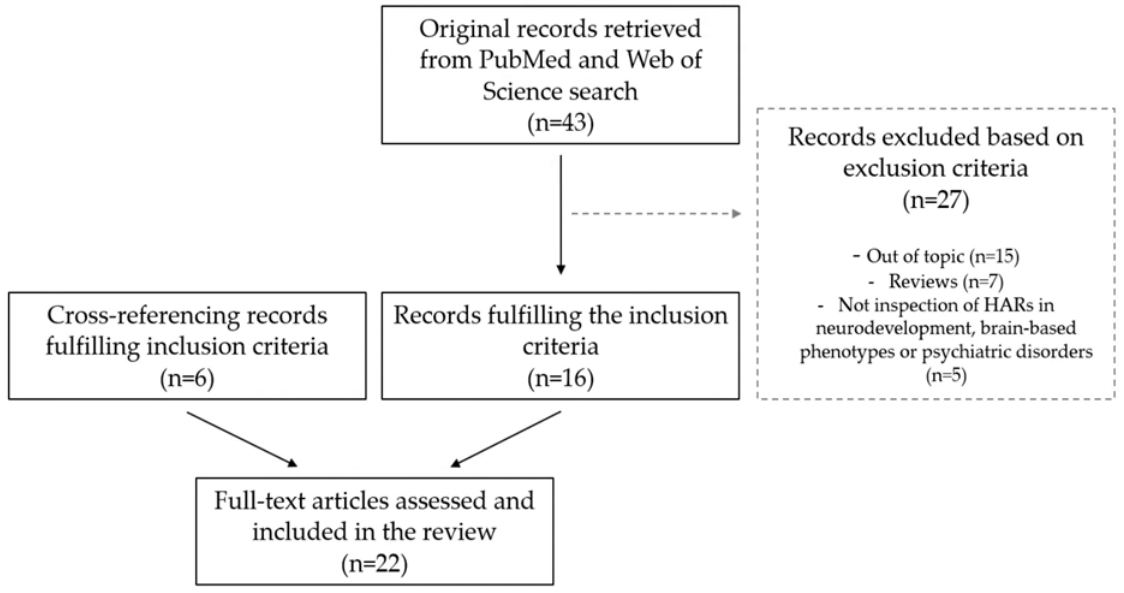
Figure 1. Flow diagram of the literature search and article selection.